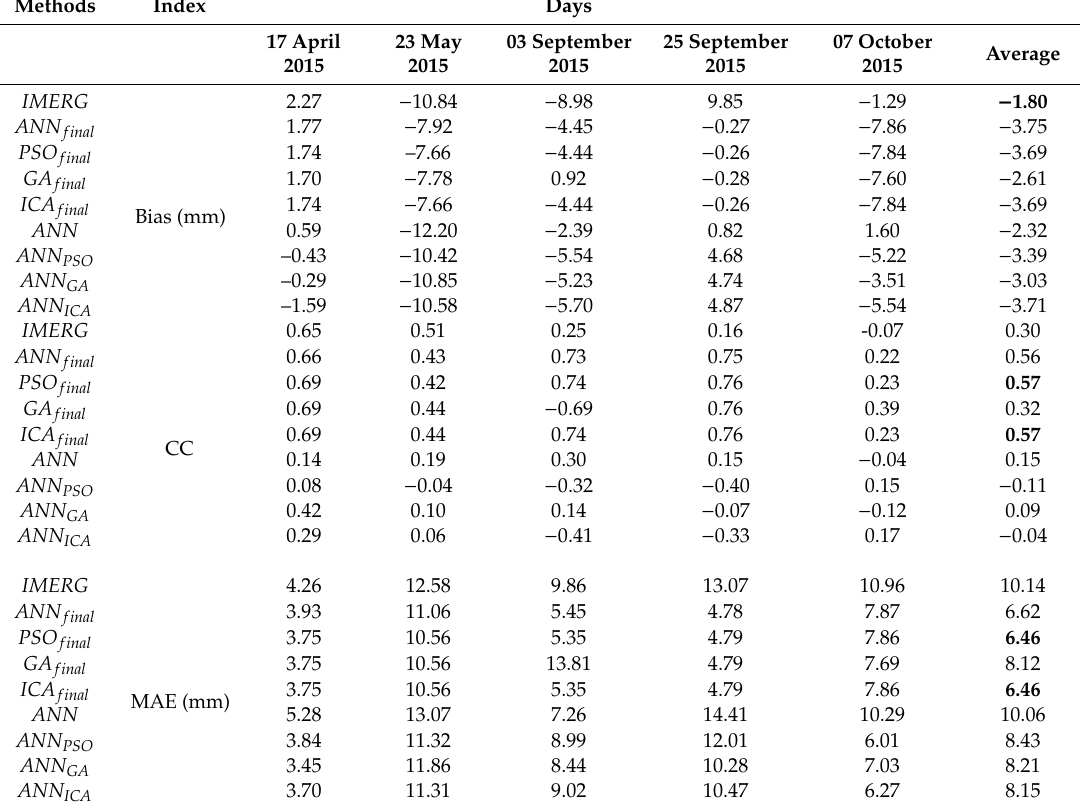
Table 7. Evaluation statistics for all final downscaled products for the selected events over Northeast